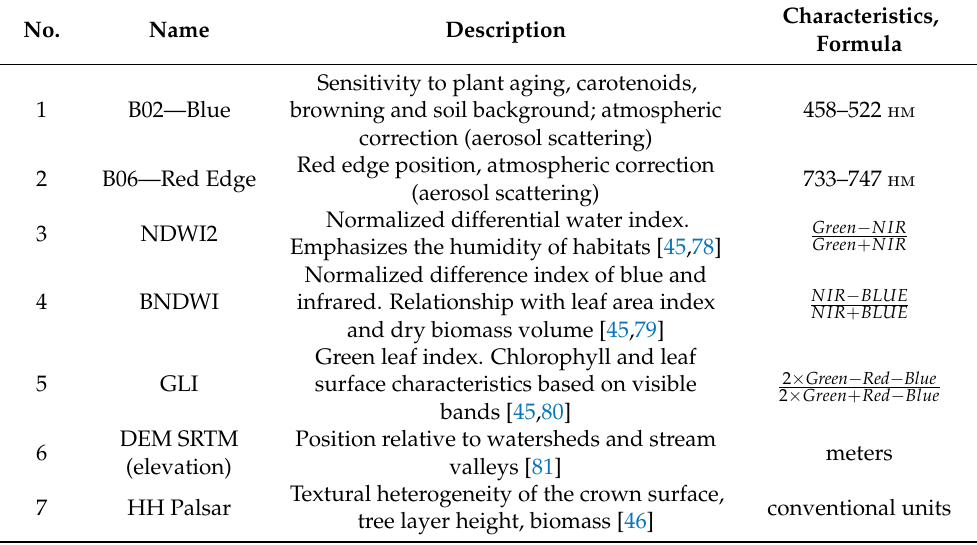
Table A1. Spatial feature raster layers with pairwise correlations less than 0.5.